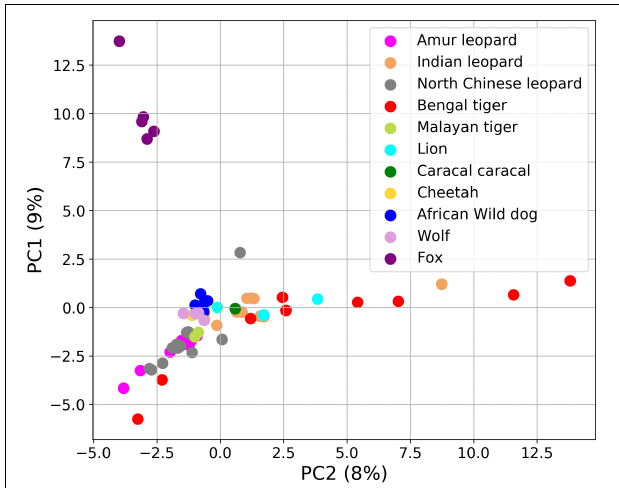
FIGURE 7 | Principal component analysis (PCA) plot showing the differences in the fecal microbial communities of 62 Carnivora individuals explaining 17% of the total variance. Fox (violet color) formed a separate cluster from all other species.